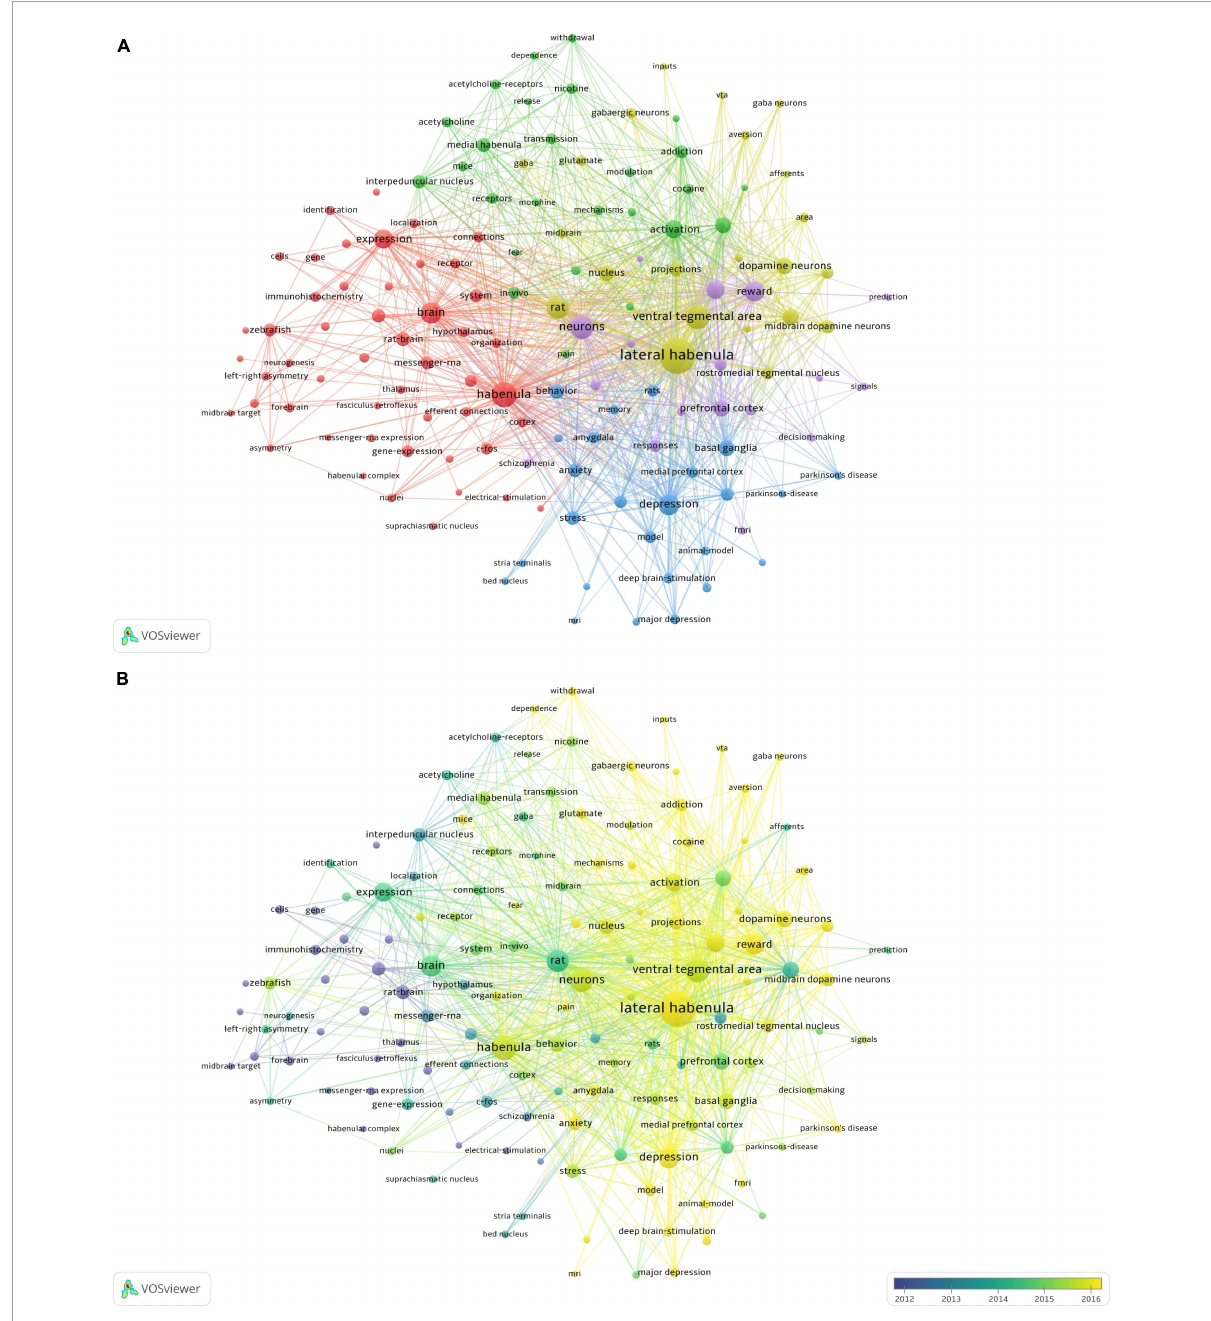
FIGURE2 Co-occurrence network analysis of keywords ( n = 140) appearing at least 20 times. (A) Classification into five clusters. (B) Average publication year for each cluster.